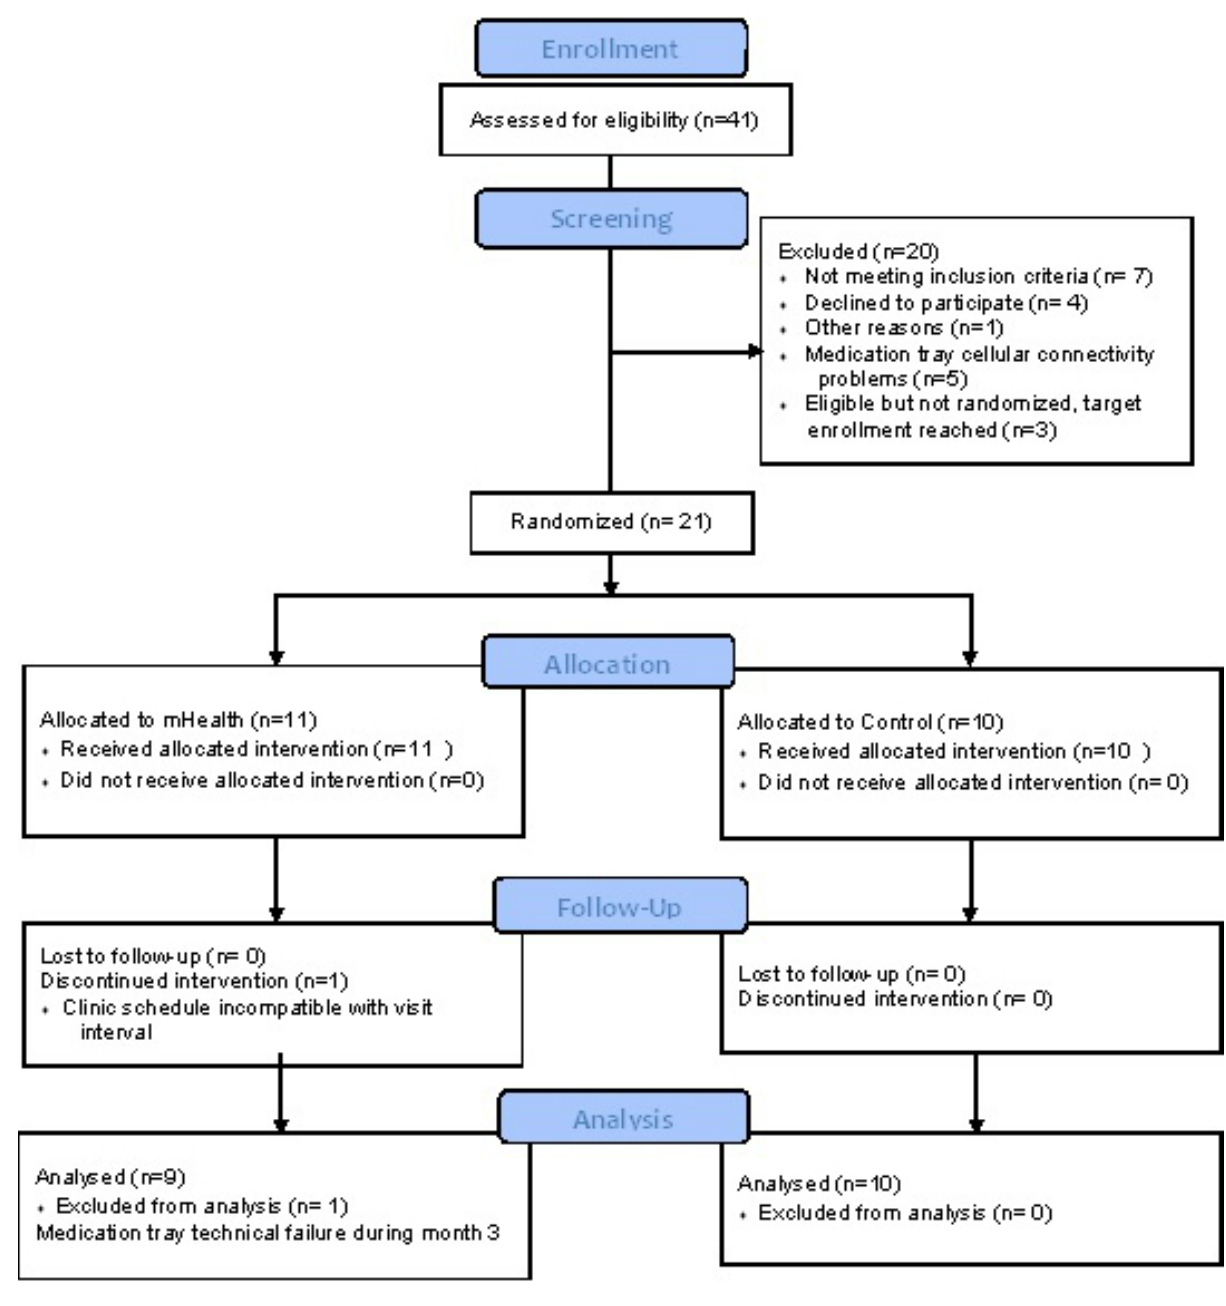
Figure 2. CONSORT flow diagram. A mobile health medication adherence and blood pressure control proof-of-concept trial in renal transplant